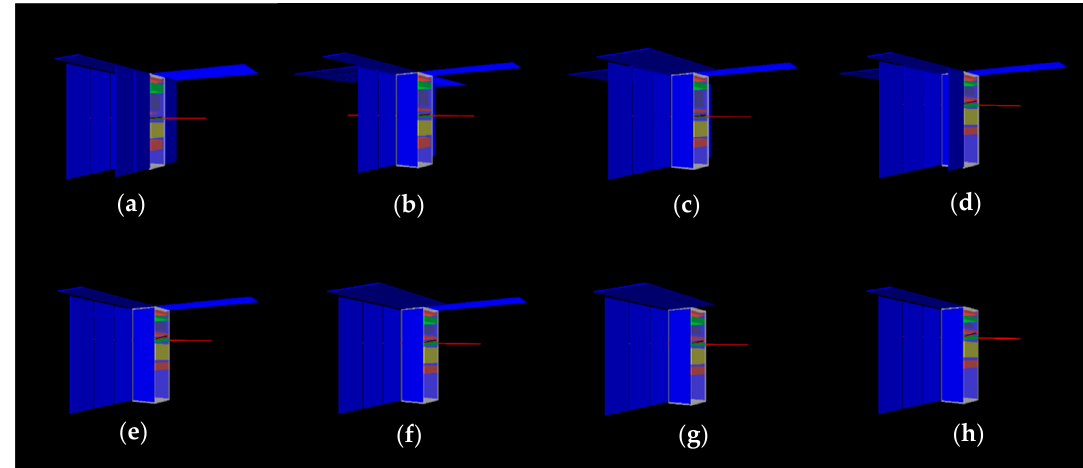
Figure 12. Rendering of the evolution of the design of the CubeSat done in MATLAB VRML. Each figure shows the best design among the population in each generation: ( a ) generation 1; ( b ) generation 12; ( c ) generation 15; ( d ) generation 20; ( e ) generation 30; ( f ) generation 80; ( g ) generation 100; ( h ) generation 150.